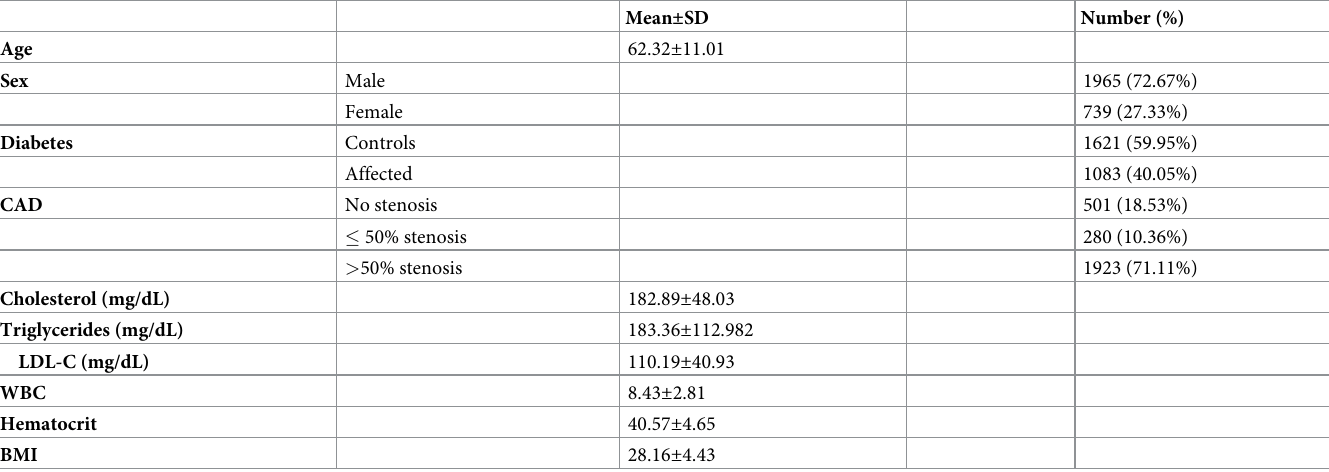
Table 1. Descriptive statistics of the